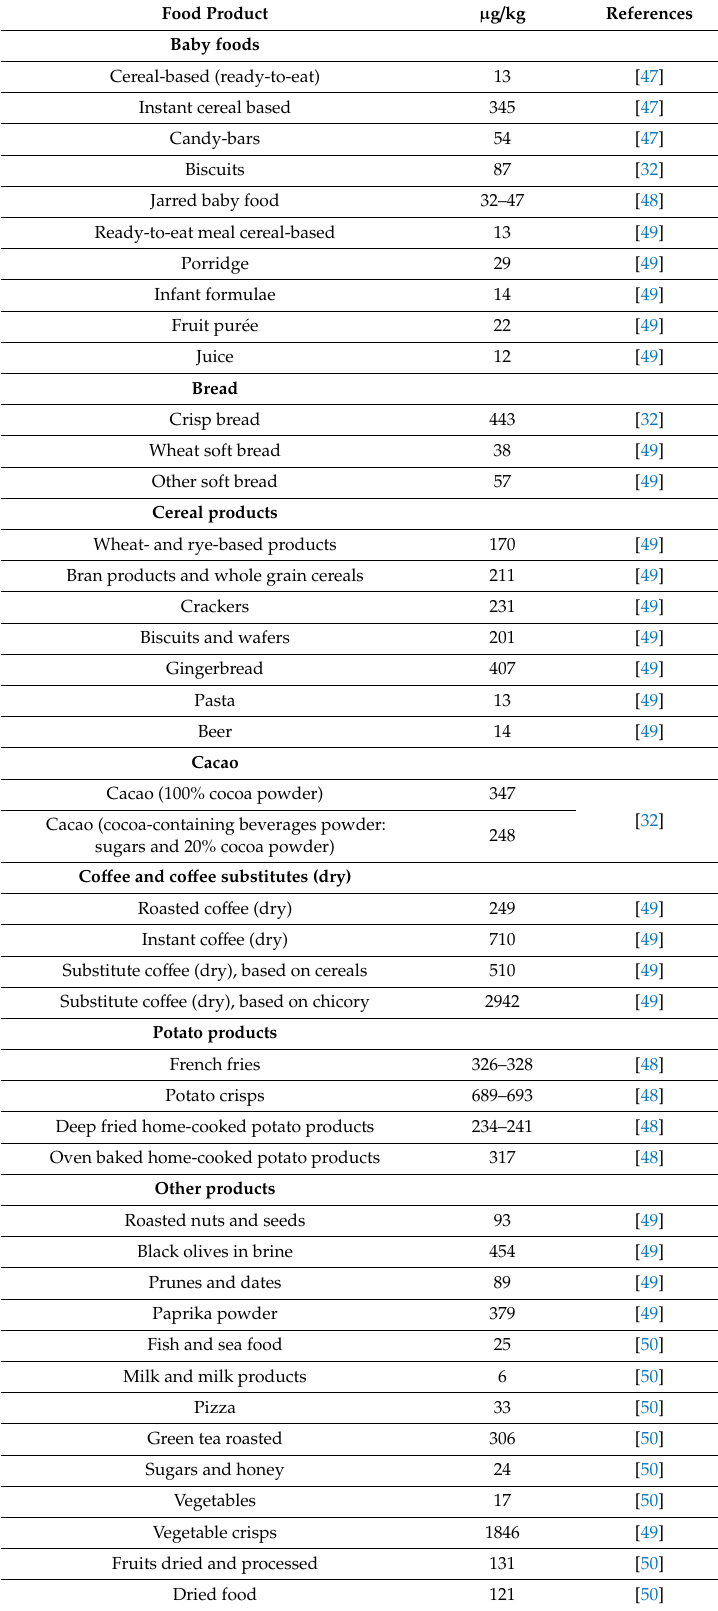
Table 1. Acrylamide content in various food products ( µ g / kg) Food